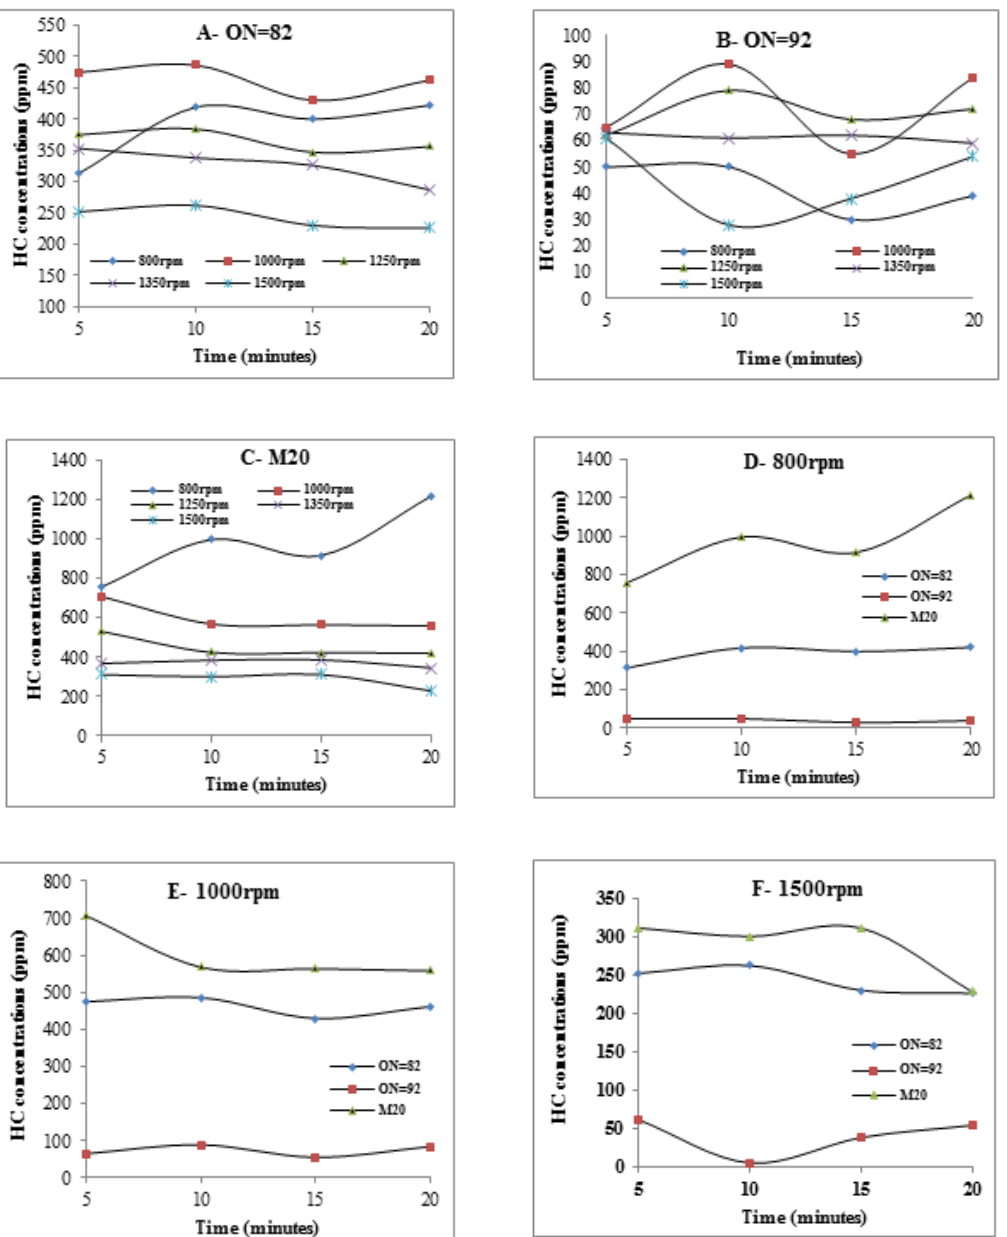
Fig. 6. the idling time effect on emitted HC for tested fuels at variable engines